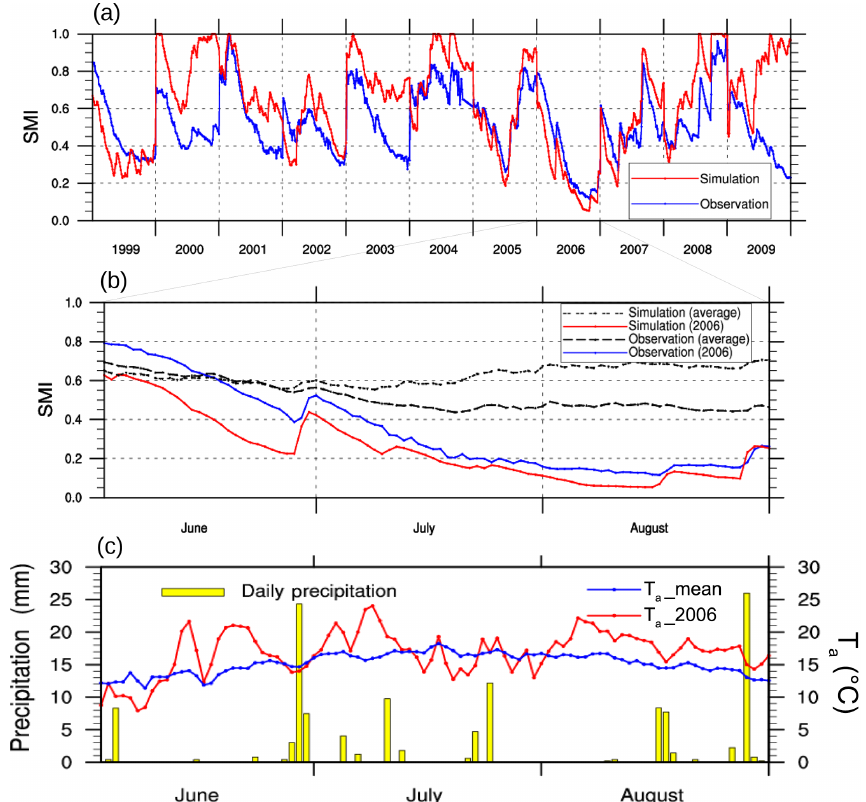
Figure 1. (a) Daily mean soil moisture index (SMI) at Hyytiälä from observation and the JSBACH simulation for the summer months (June, July, August) in the 11-year study period (from 1999 to 2009). (b) Daily mean SMI at Hyytiälä from observation and the JSBACH simulation for the summer months in 2006; the two black dashed lines represent the averaged daily SMI in the summer months over the 11-year study period from observation and the JSBACH simulation. (c) Daily mean air temperature ( T a ) in the summer months of 2006 and the averaged daily mean T a in the summer months over the 11-year study period at Hyytiälä from observation, meanwhile, the daily precipitation amount in 2006 is shown as the bar